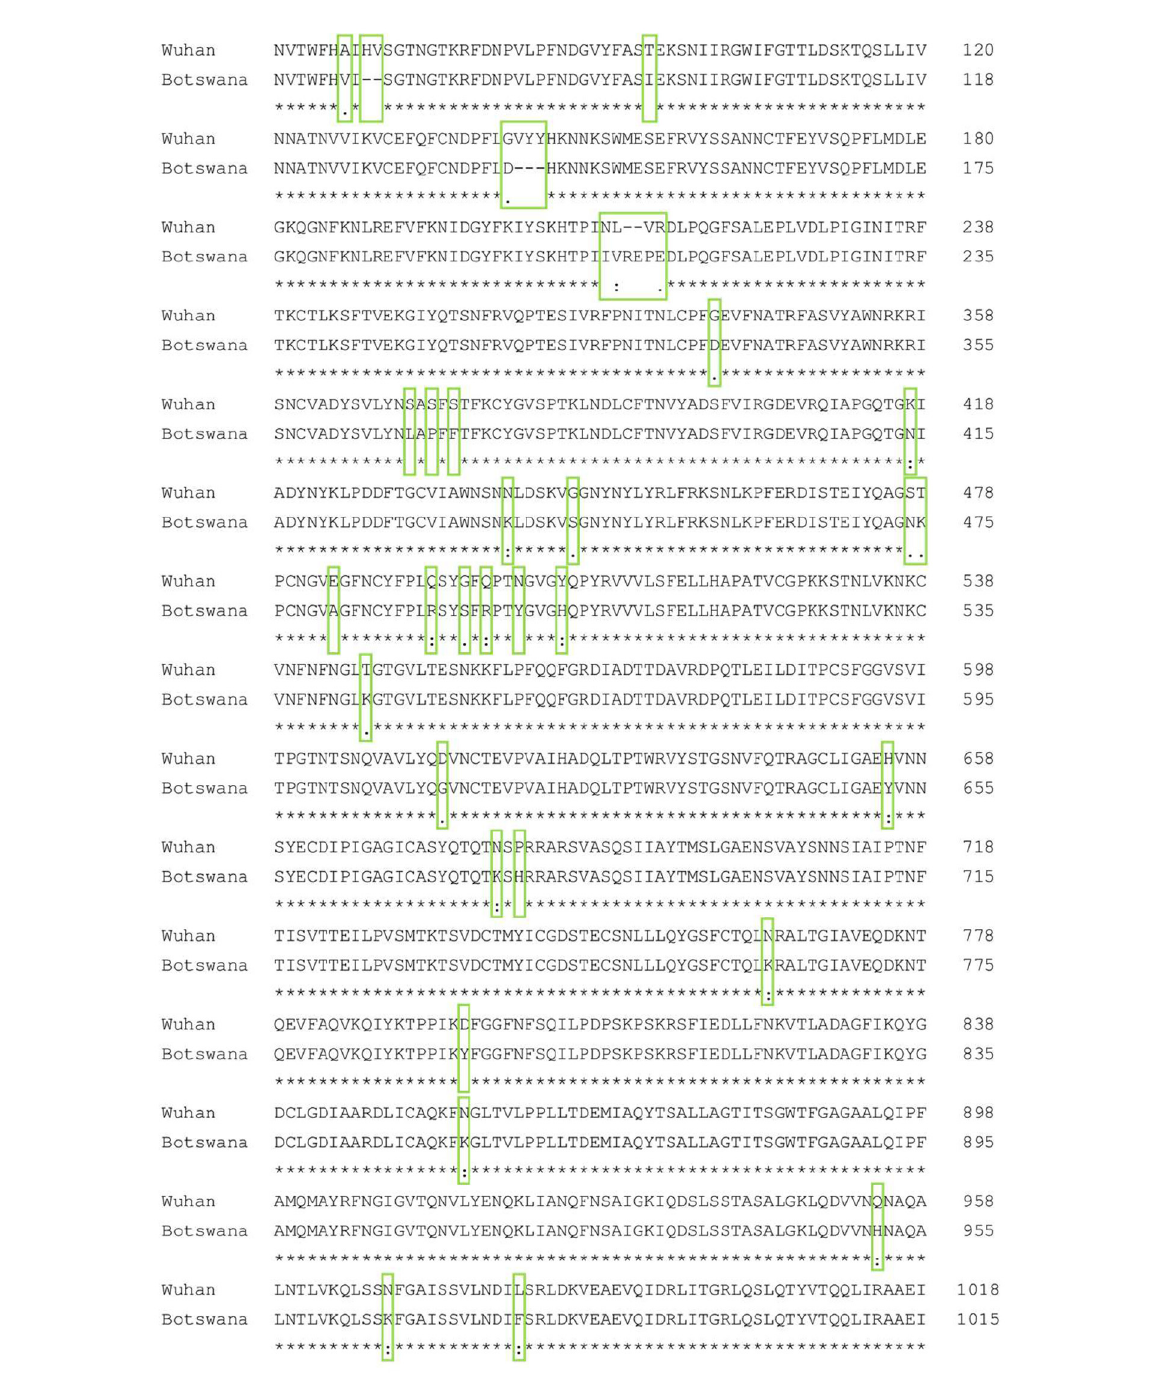
FIGURE1 Spike protein amino acid sequence alignment of the Wuhan and Botswana variants. The differences between the two sequences are marked with a green box. A consensus line is shown below the nucleotide alignment of the two variants, with the following symbols indicating the degree of conservation observed for each compared pair: “ * ” (identical residues in all sequences), “:” (highly preserved column), “.” (weakly preserved